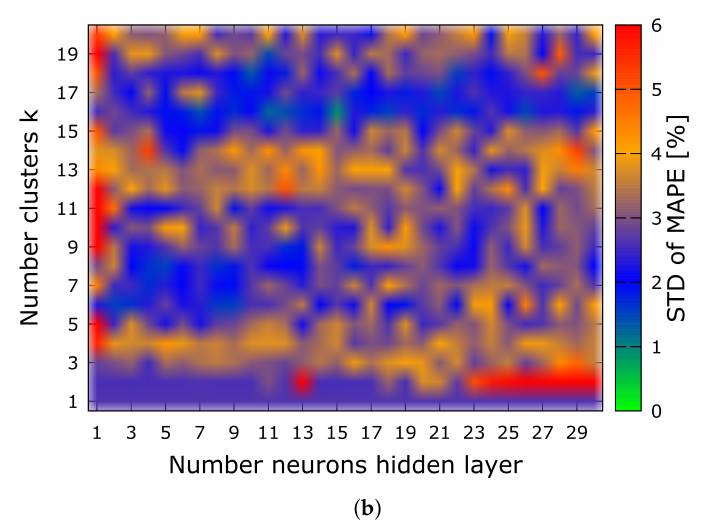
Figure 2. MAPE results of grid search, mean ( a ) and (STD) ( b ).